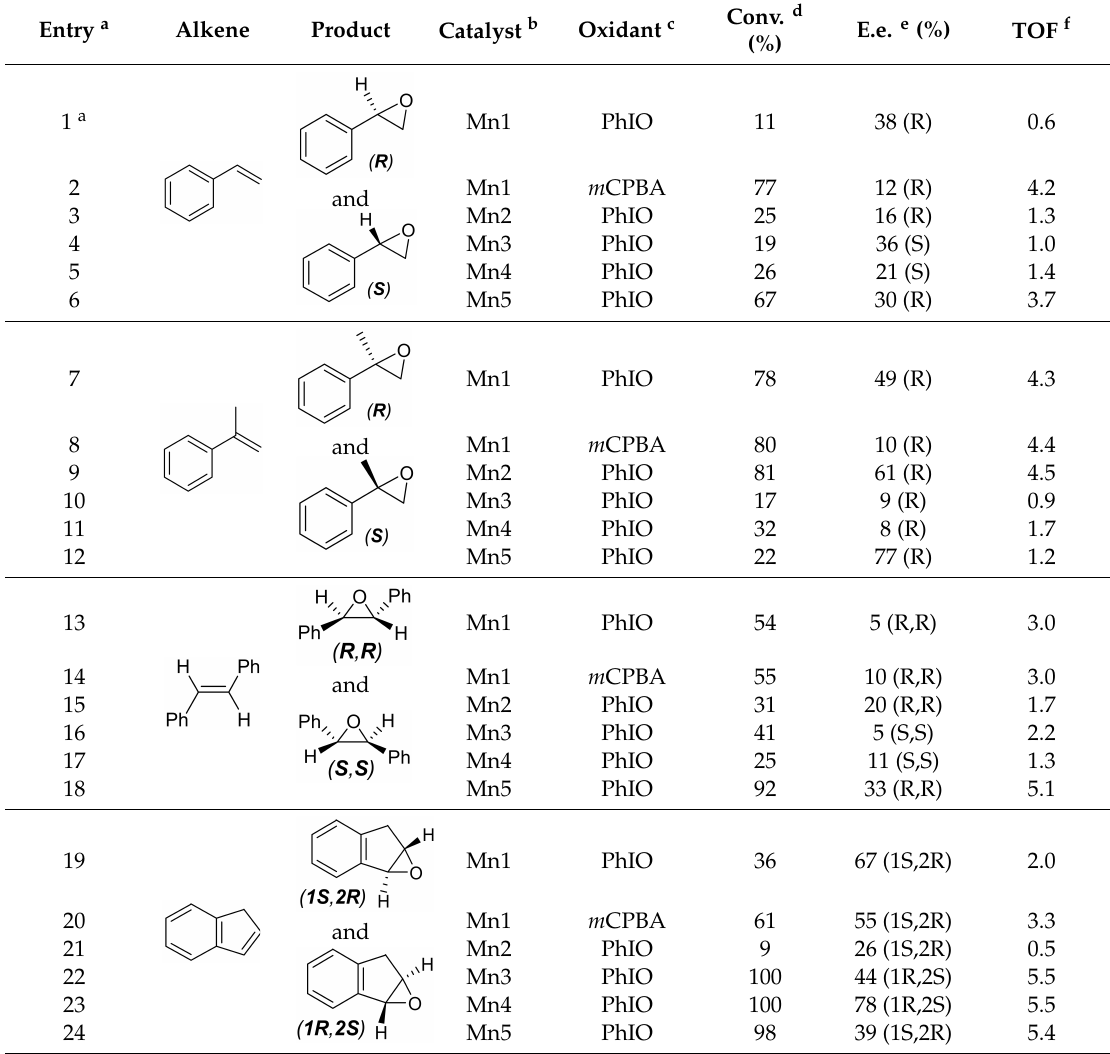
Asymmetric epoxidation of unfunctionalized alkenes catalyzed by homogeneous (tartrate-salen)Mn(III) polymer